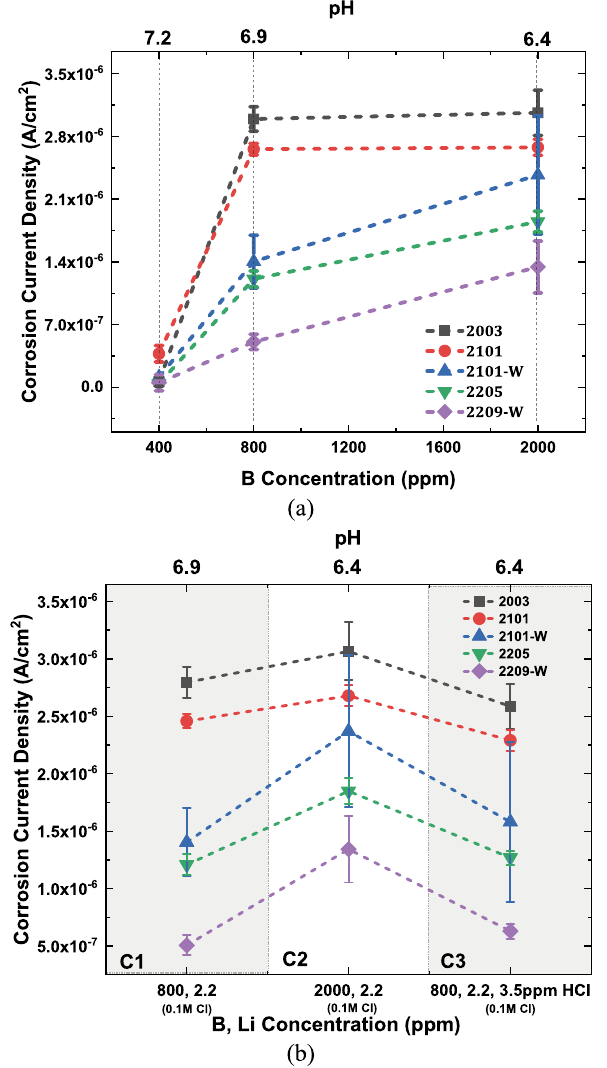
Fig. 12 a Increase in corrosion current density with increasing B concentration and decreasing pH for 10 4 h aged DSS alloys, and b effect of boron concentration and pH on i Increasing boron concentrations leads to a decrease in corrosion resistance of the DSS alloys. All the test solutions had 0.1 M chloride